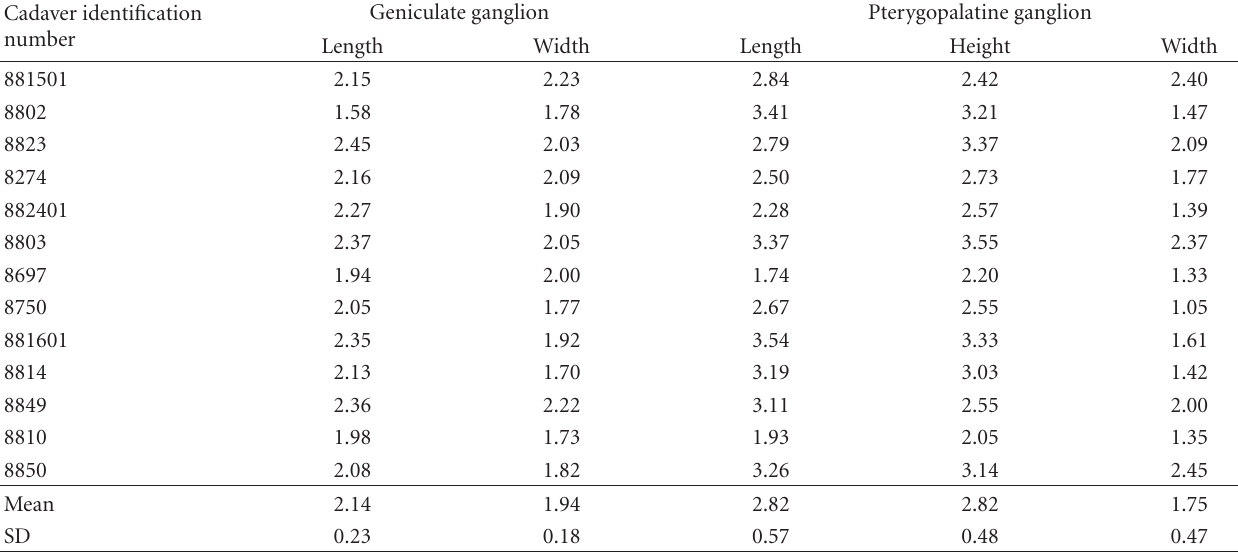
Table 3: Measurements of the geniculate and pterygopalatine ganglia in